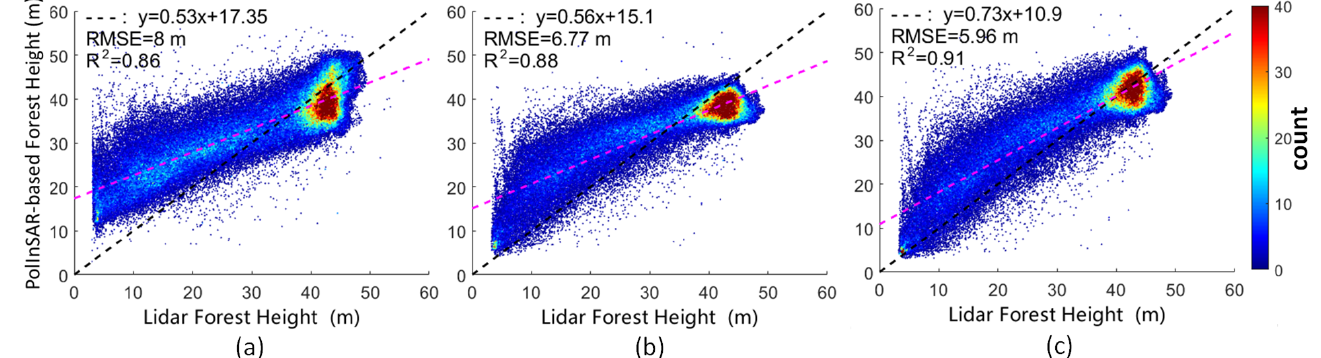
Figure 8. Statistical results of tropical forest height estimation. Red indicates dense scatter, and blue indicates sparse scatter. ( a ) Dual-baseline PolInSAR forest height inversion results based on the RVoG model; ( b ) dual-baseline PolInSAR forest height inversion results based on the PCT model; ( c ) dual-baseline PolInSAR forest height obtained by correcting the height of canopy scattering peak.